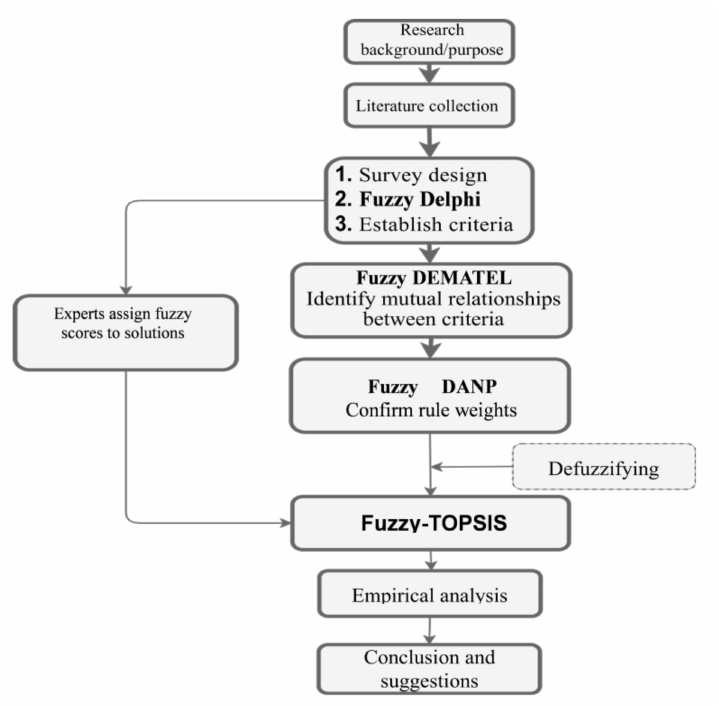
Figure 2. Research process flowchart.